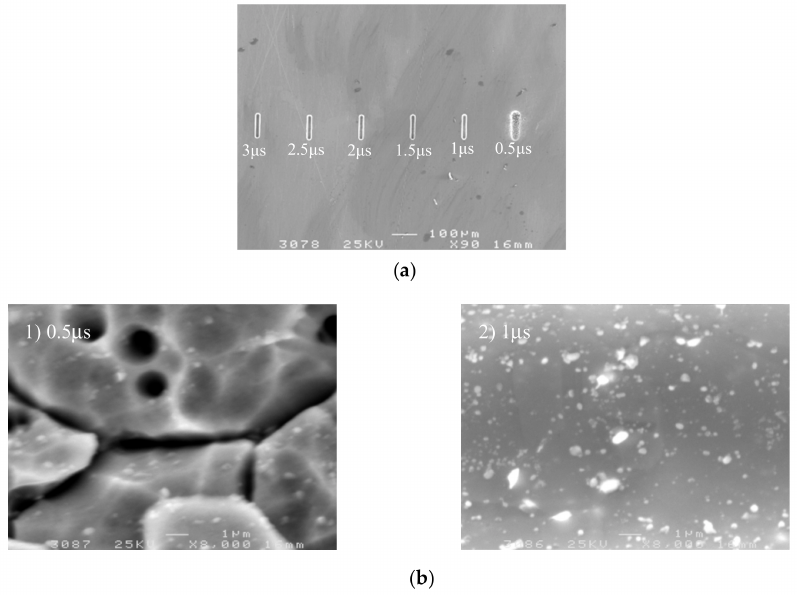
Figure 10. The microgroove under different pulse periods. ( a ) The SEM image of the microgroove; ( b ) The appearance of the